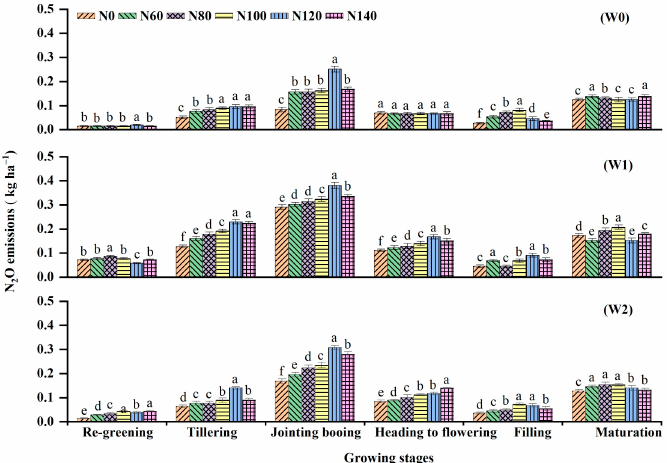
Figure 6. Seasonal N 2 O emissions affected by irrigation regimes with different N application rates during the rice-growing period. W0, W1, and W2 represent continuous flooding, intermittent irri- gation, and control irrigation (W2), respectively. Urea application at rates of 0 (N0), 60 (N60), 80 (N80), 100 (N100), 120 (N120), and 140 (N140) kg N ha − 1 . Values followed by the different letter are significant different at p < 0.05.